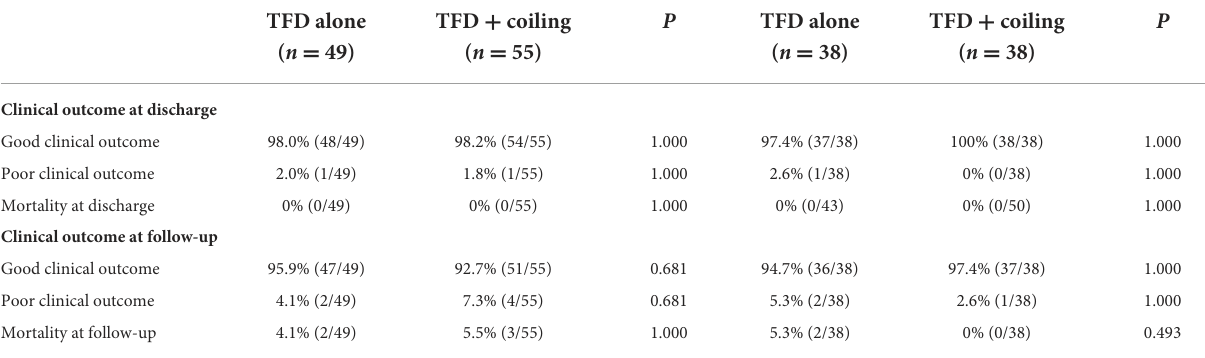
TABLE 3 Clinical